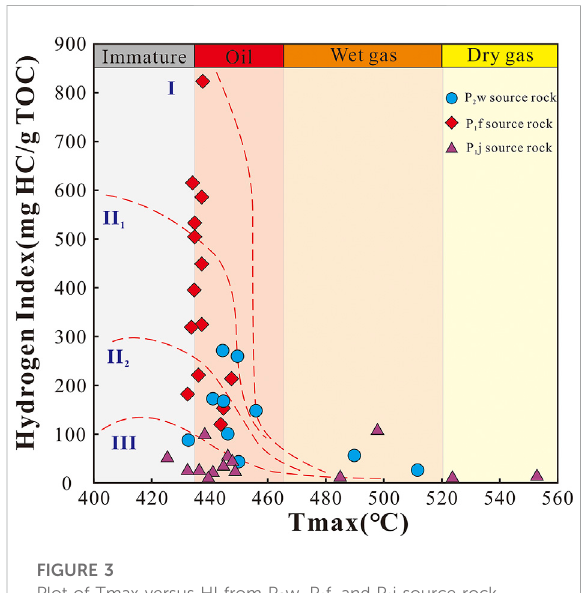
FIGURE 3 Plot of Tmax versus HI from P 2 w, P 1 f, and P 1 j source rock samples.